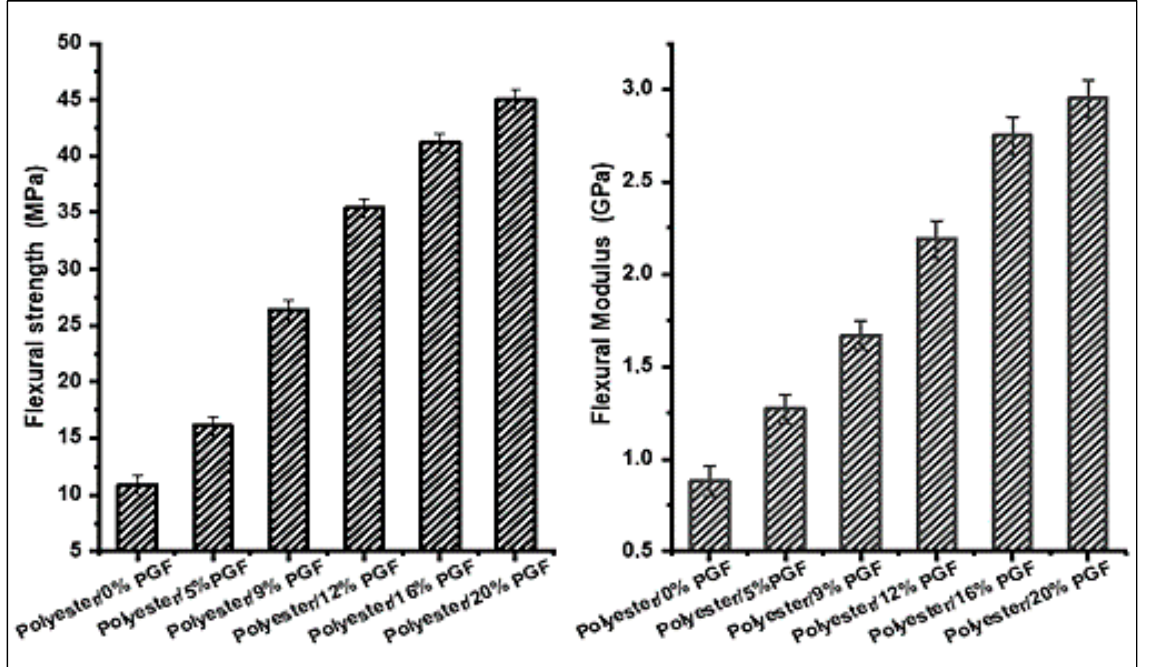
Figure 9. Effect of phosphate glass fiber content on flexural strength and modulus.